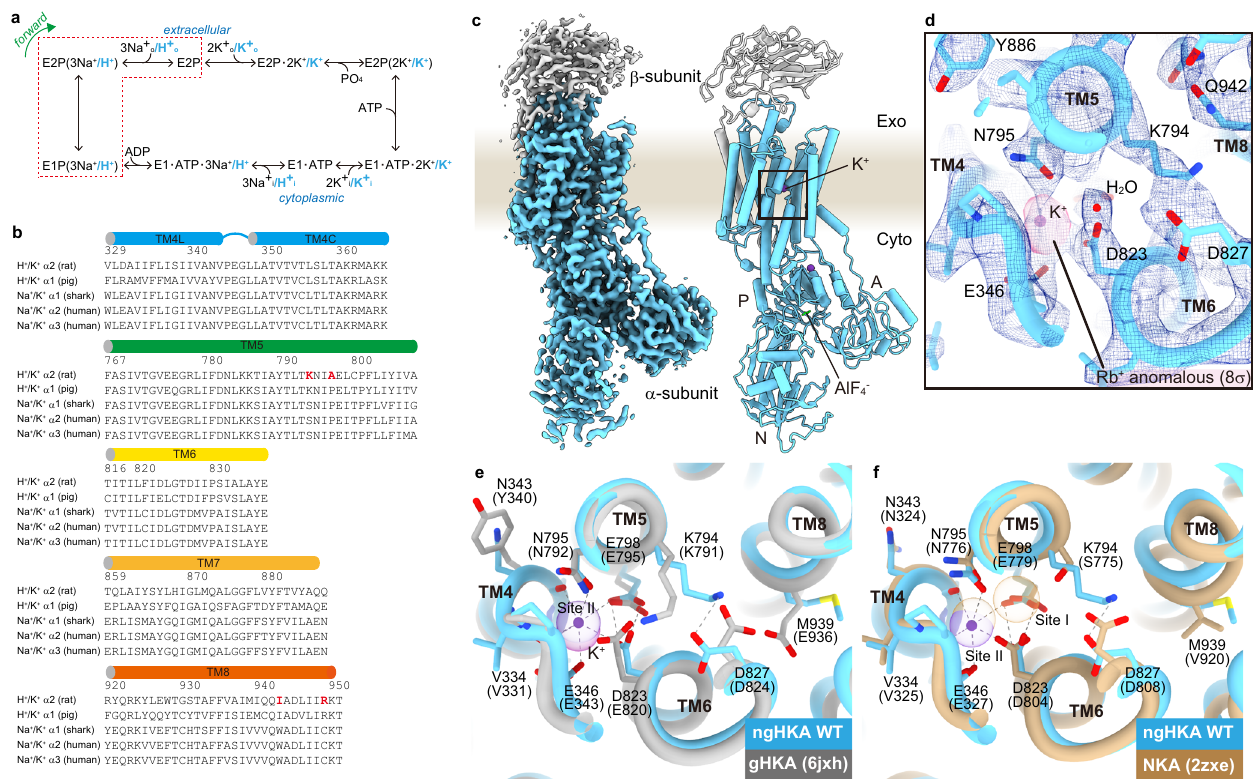
Fig. 1 | Catalytic cycle and crystal structure of non-gastric H + ,K + -ATPase (ngHKA). a Post-Albers reaction scheme of H + ,K + -ATPase (HKA, cyan) and Na + ,K + - ATPase (NKA, black). b Sequence alignment of the transmembrane ion-binding sites-forminghelicesinP-type 2C ATPases,TM4-TM8.Aminoacidsmutatedinthis study are shown as red. c Electron density map (surface, 2 σ ) and cartoon model (cylinders)ofthengHKAintheAlF 4 -inhibited,K + -occludedstate,mirroringthe(K + ) E2-P i state of the catalyticcycle.The α - and β -subunitsare shown in cyanand gray, respectively. K + ions (one within the membrane domain, one in cytoplasmic domains) are shown as purple spheres. The cytoplasmic A-, P-, and N-domains are